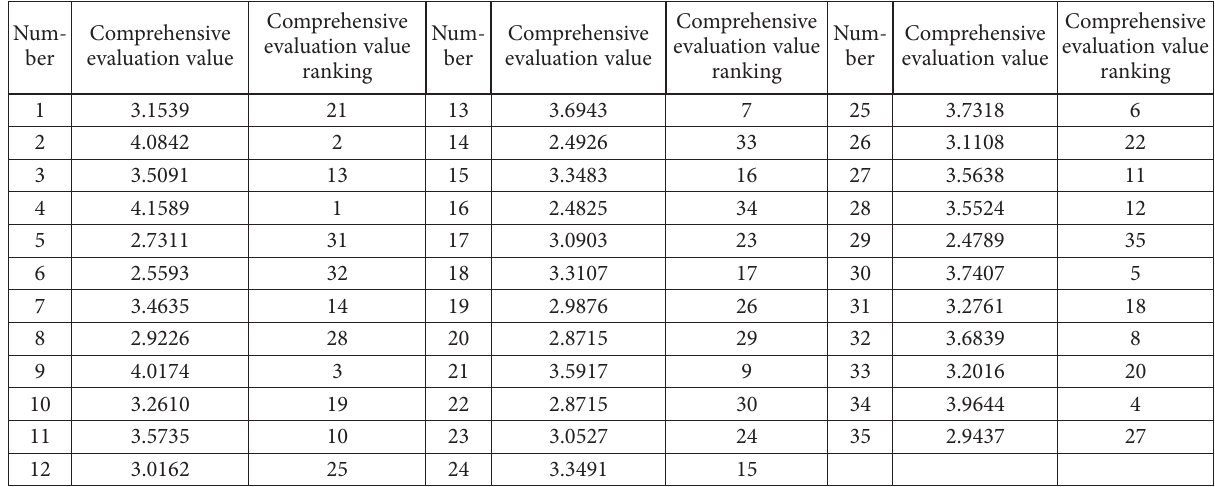
Table 5. Principal factor comprehensive evaluation value and ranking of plant landscape in Jinlong lake wetland park Num- Comprehensive ber evaluation